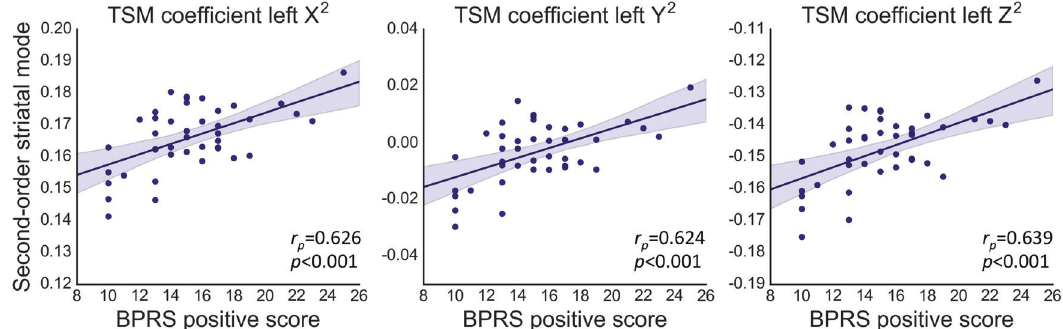
Fig. 3 Associations between BPRS positive subscale scores and the second-order connectivity mode in left striatum in patients with fi rst- episode psychosis. To visualize these associations, partial correlations ( r p ) are shown between BPRS positive scores and the TSM coef fi cients that most strongly contributed. The shaded areas represent the con fi dence intervals of these correlations.